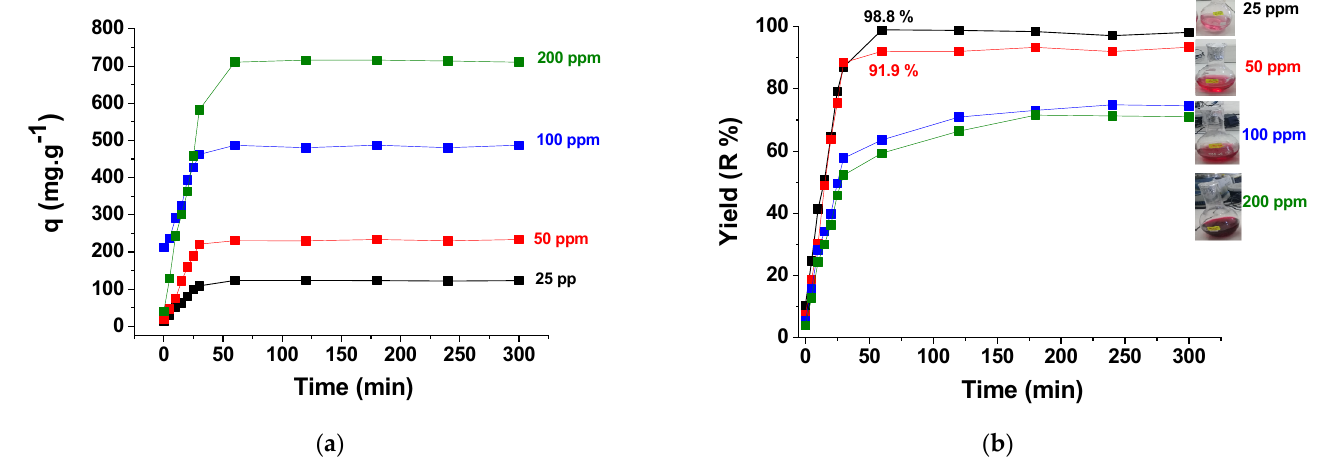
Figure 6. Effect of the initial Az concentration on ( a ) the adsorption capacity of Ni/Zn LDH adsorbent and ( b ) the Az removal ratio.